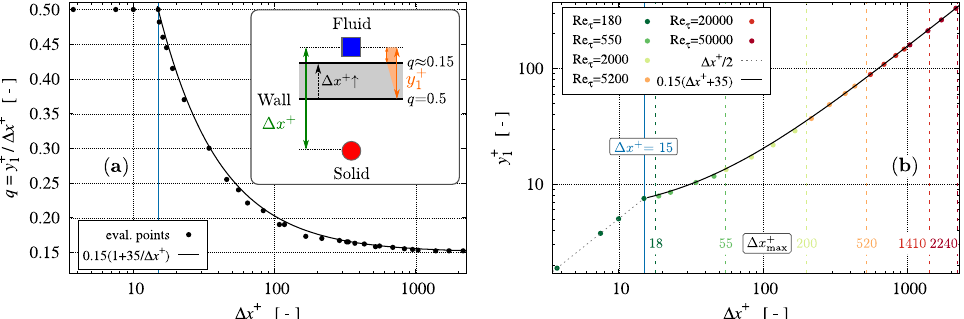
Figure 3. Evolution of the suggested non-dimensional wall distance of the wall-adjacent fluid node y + in normalized ( a ) and non-normalized ( b ) format, depending on the grid resolution ∆ x + as 1 described in Equation (10). Colored dots display evaluated discrete y + number and grid. Furthermore, the reasonable maximum resolution for each of the underlying Reynolds numbers is illustrated by colored dashed vertical lines.